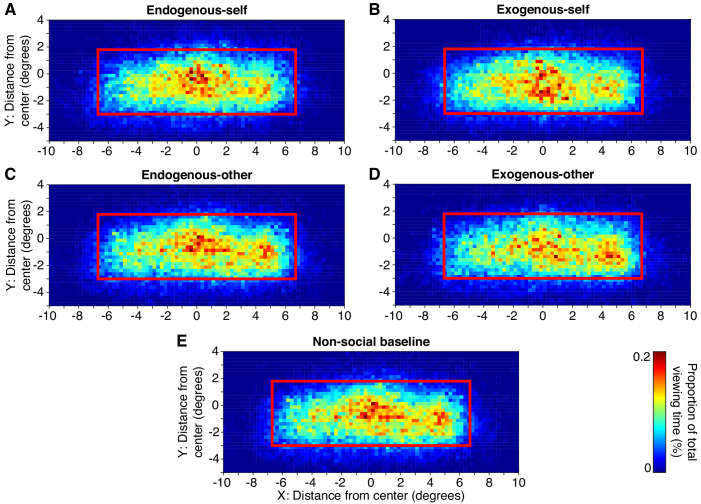
Eye tracking results.Subjects tended to fixate in a similar spatial pattern across the screen, and engage in similar saccade dynamics, regardless of the type of story presented. No significant ability to decode the story type based on the pattern of eye movement was obtained. The red rectangle in the heat maps in panels A-E indicates the area of the screen within which the story text appeared.